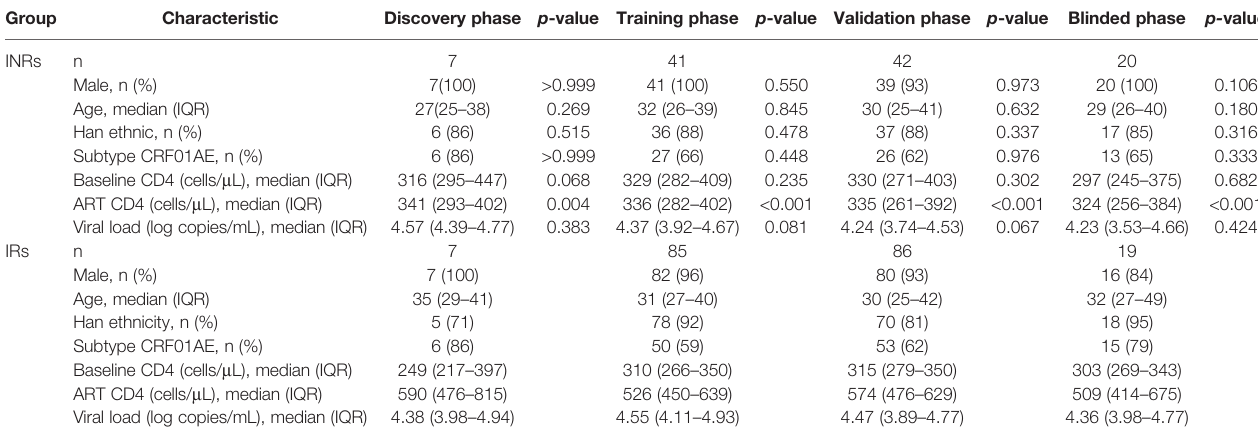
TABLE 1 | Demographic and clinical characteristics of patients included in this study.